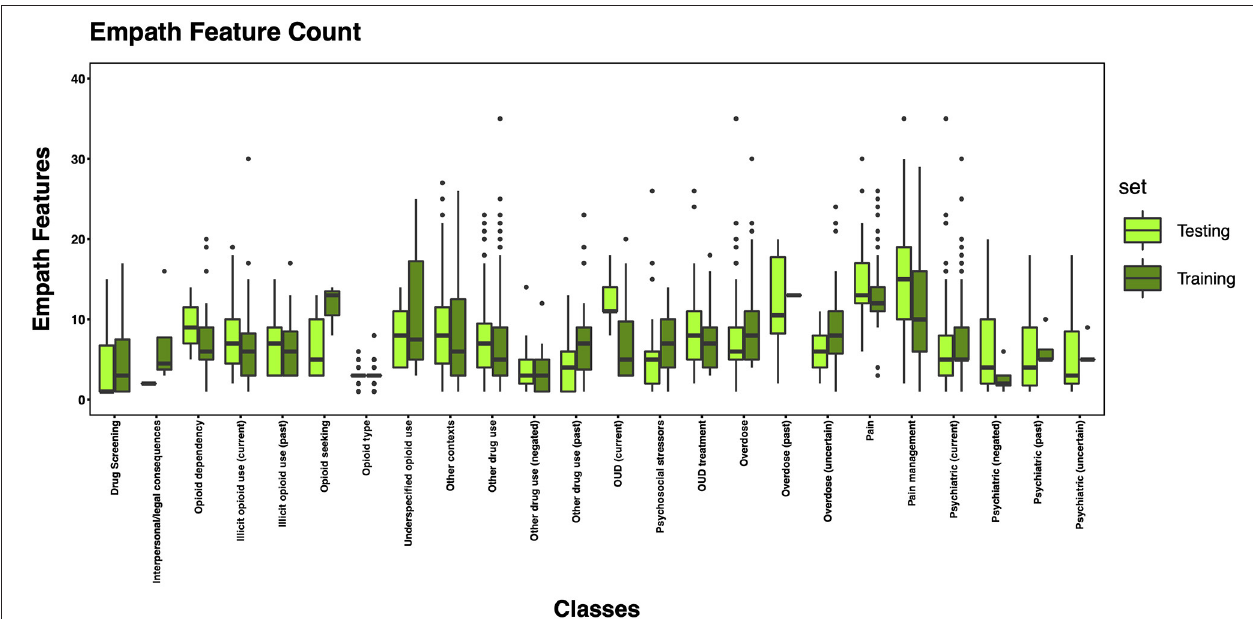
FIGURE 5 | Boxplot of the mean count of Empath features per class, comparing training and testing sets.